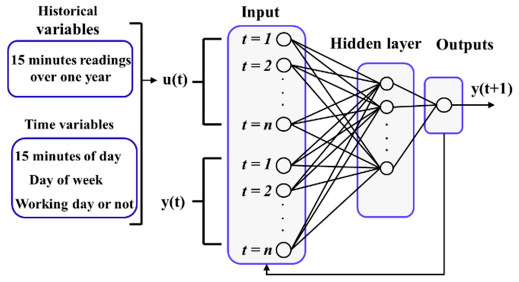
Figure 6. Structure of estimation model based on NN.